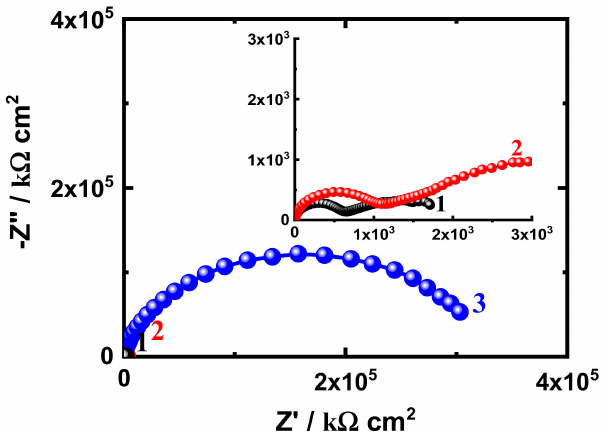
Figure 7. Nyquist plots obtained for (1) SN1, (2) SN3, and (3) SN5 after their immersion for 10 days in 3.5% NaCl solutions.